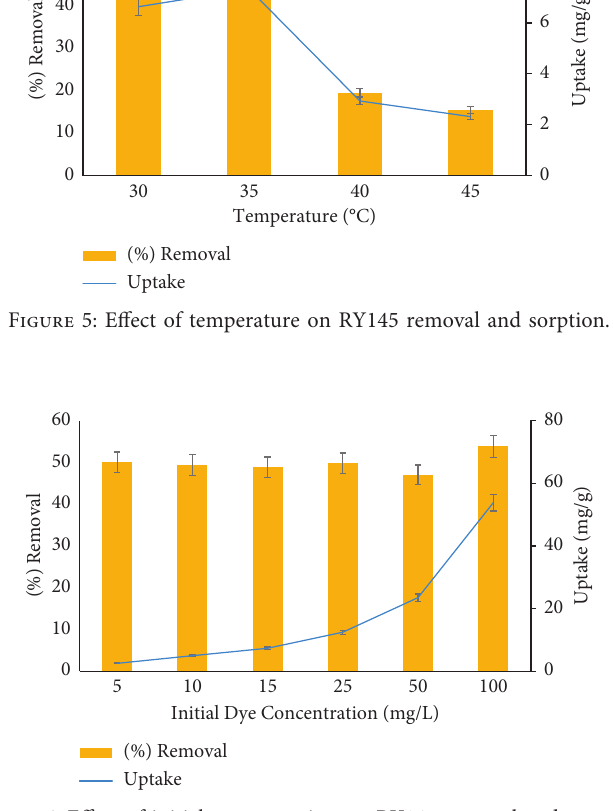
Figure 6: Effect of initial concentration on RY145 removal and sorption.